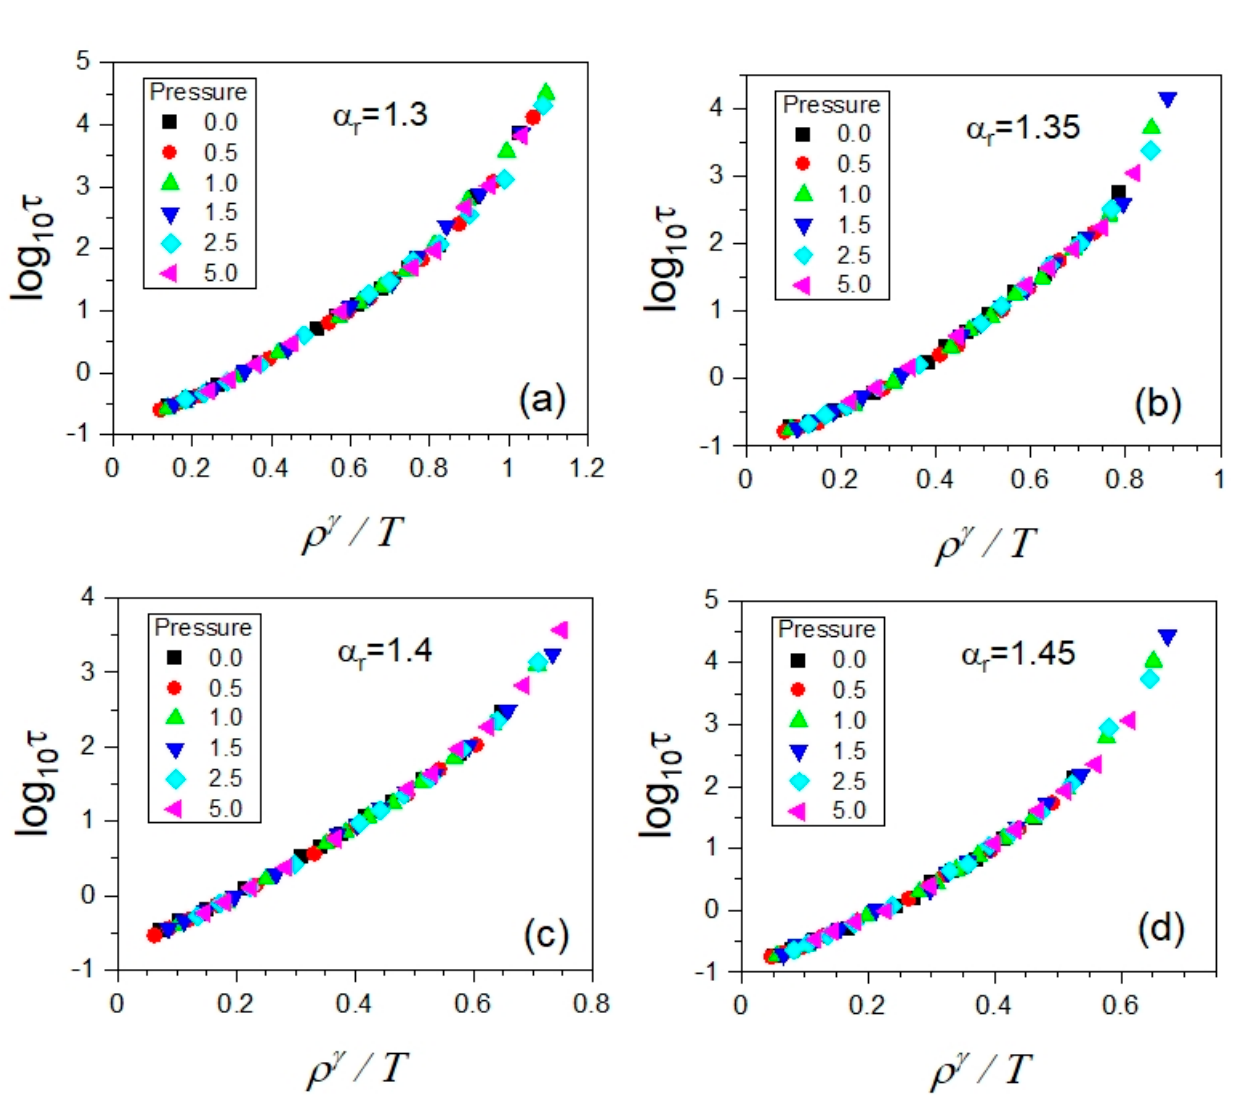
Figure 6. Plots of the density scaling of the translational relaxation times τ collected in the supercooled liquid state in the GB model, which is successfully carried out by using the values of the density scaling evaluated based on the density scaling criterion given by Equation (2). In the separate panels, there are the cases shown for the different anisotropy aspect ratios α r : ( a ) 1.30, ( b ) 1.35, ( c ) 1.40, and ( d ) 1.45, respectively.